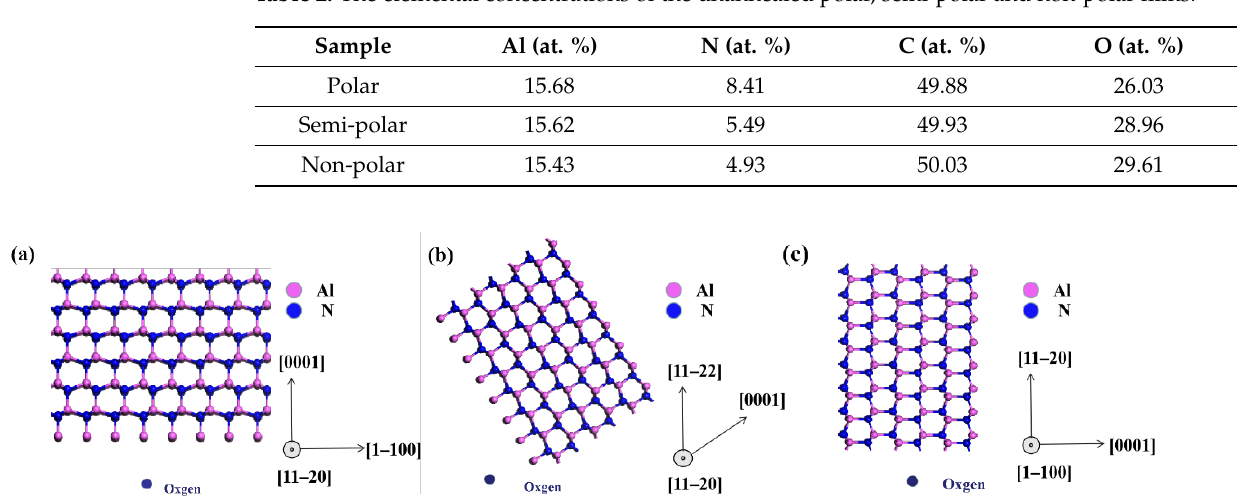
Figure 3. Impurity-binding model for ( a ) polar (0001), ( b ) semi-polar (11 – 22) and ( c ) non-polar (11 – 20)